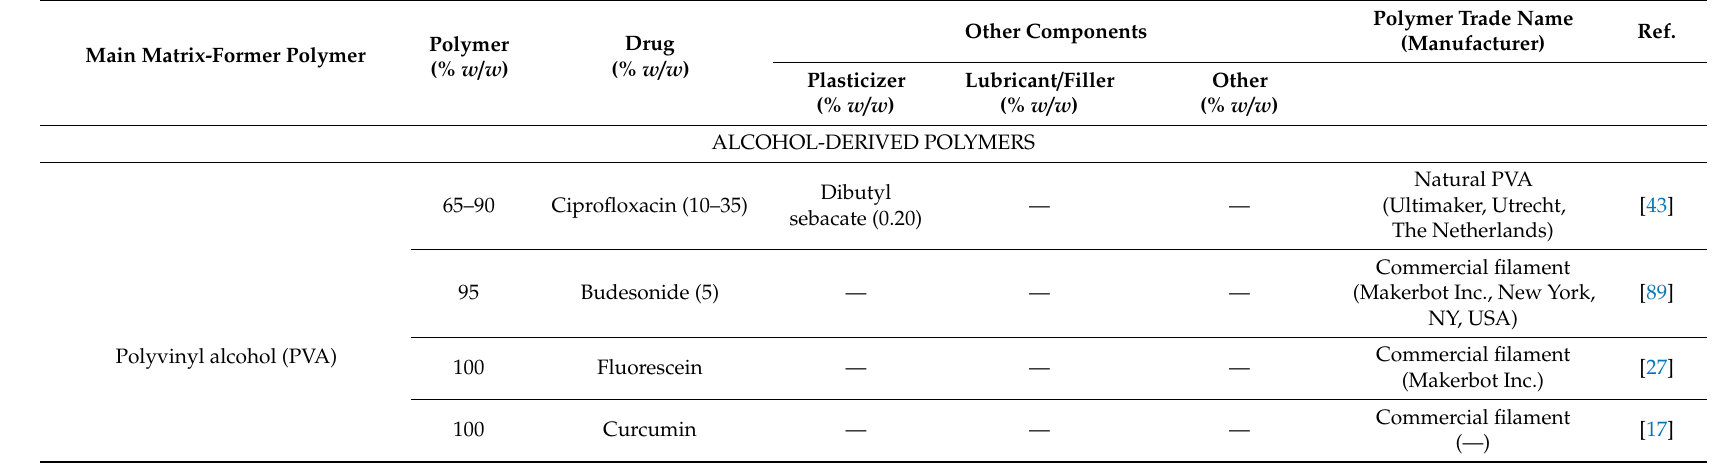
Table 3. Pharmaceutical grade polymers used to prepare filaments (HME) for FDM 3D printing. The composition (% w / w ) of the filaments (polymer, drug and adjuvants) and polymer manufacturer are